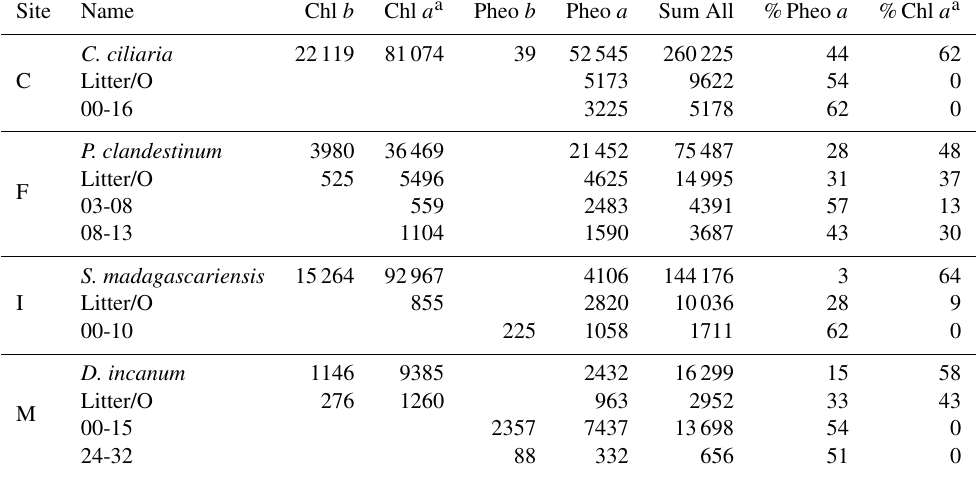
Table 2. Relative compound abundance in a plant sample and the litter and soil horizons on which δ 15 N pheo was measured, grouped by site. Values reported are summed peak areas of absorbance at 660nm in units of milli-absorbance units, summed for all collected injections of the sample. Values are first reported for individual compounds and then compared with the summed area of all detected chlorin peaks, first as absolute values and then as a percentage of chlorin peak area. Chlorophyll is abbreviated Chl.